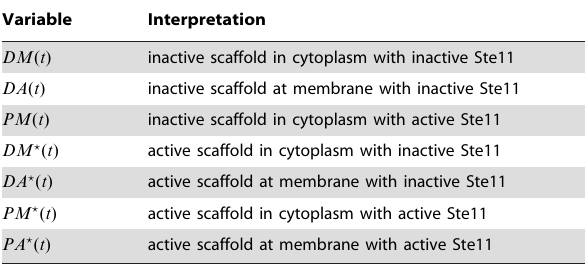
Variable Interpretation